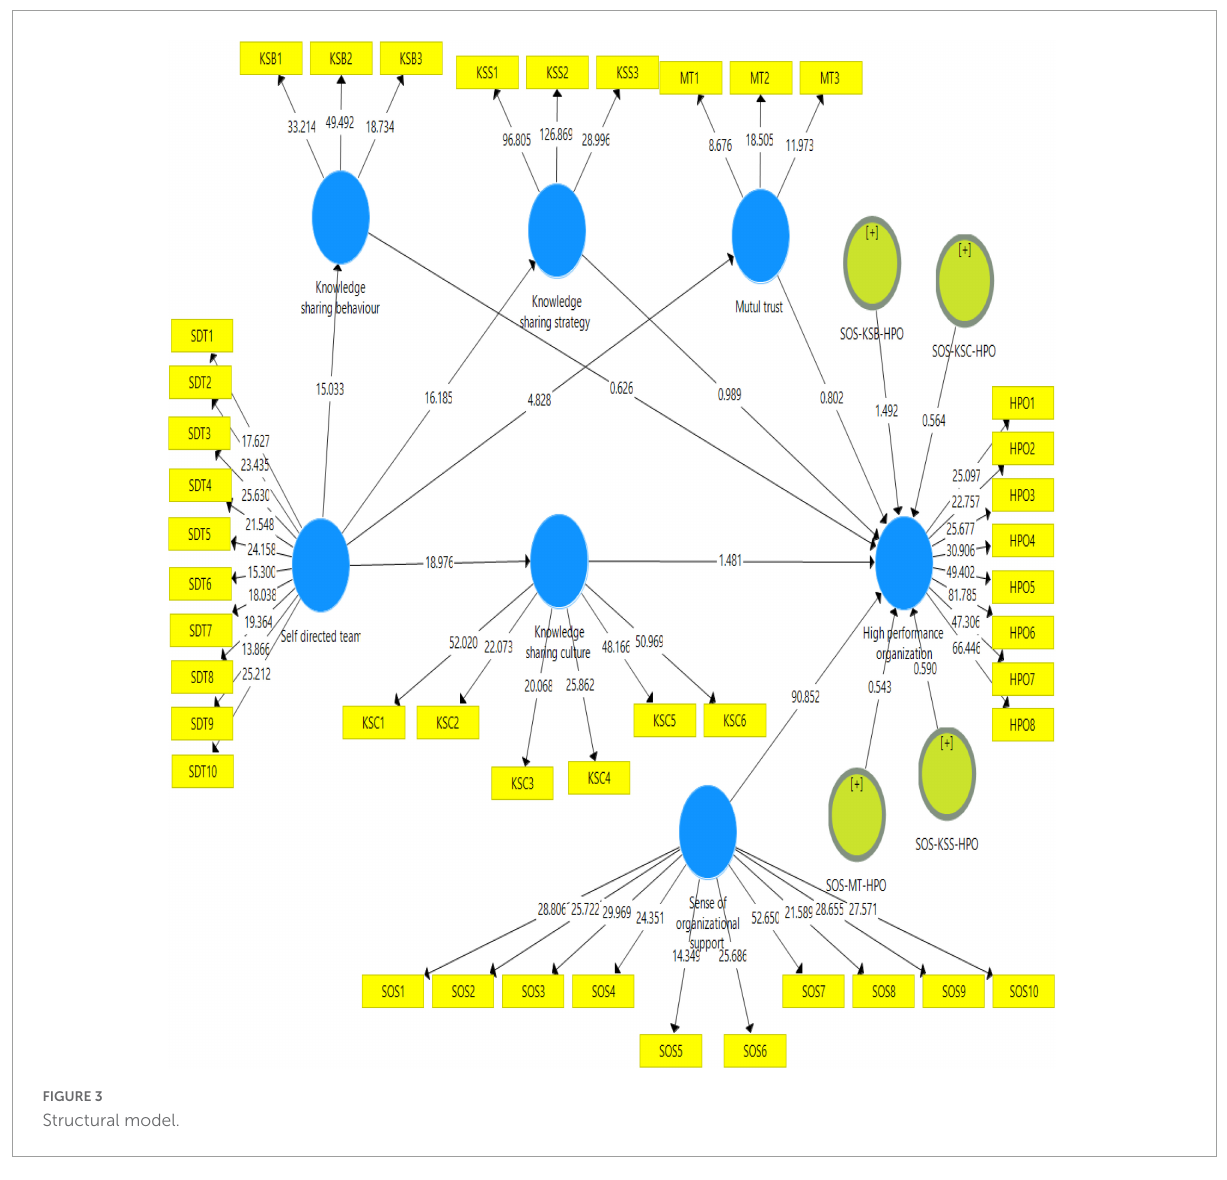
FIGURE3 Structural model.